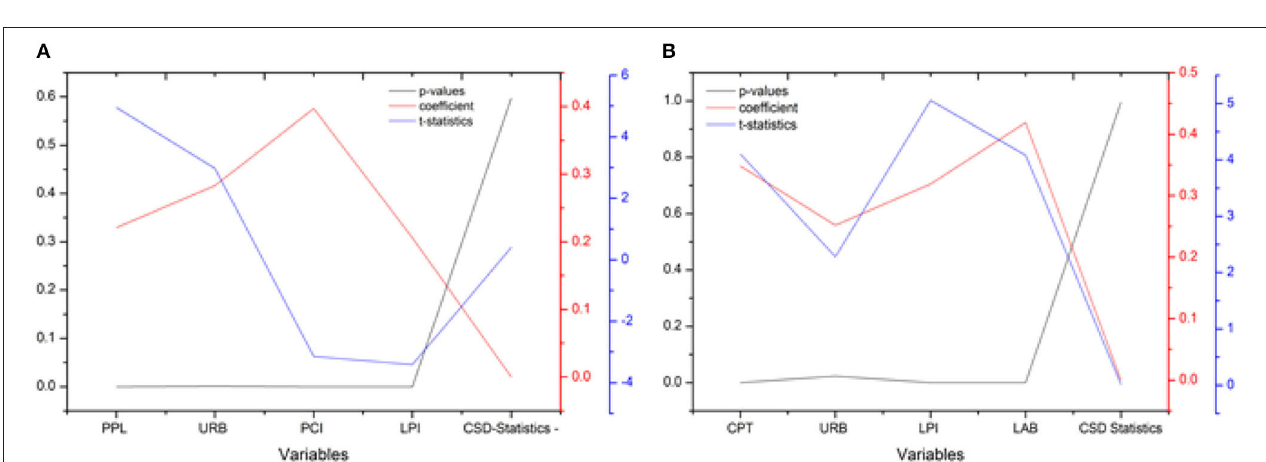
Frontiers in Public Health |